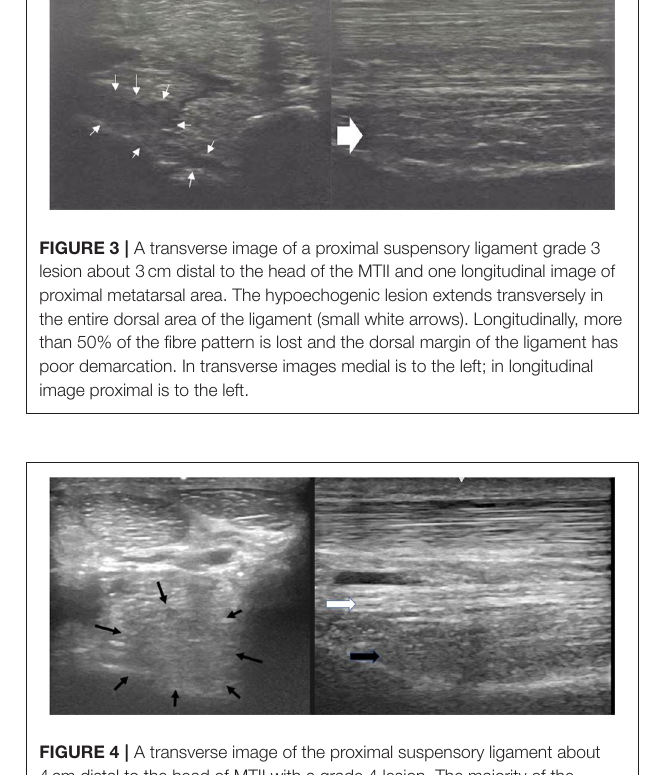
FIGURE 2 | A transverse image of a proximal suspensory ligament grade 2 lesion (small white arrows) about 3cm distal to the head of the MTII. The character of the lesion is similar to the Figure 1 , but with larger cross-sectional area. In the longitudinal image there is a disruption of the fibre pattern (big white arrow) in the dorsal aspect of the ligament. In transverse images medial is to the left; in longitudinal images proximal is to the left.